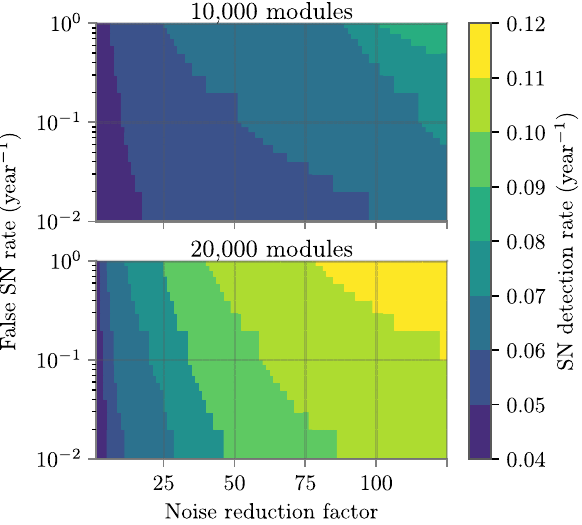
Fig. 10 CCSN detection rate for hypothetical detectors with 10,000 (upper) and 20,000 (lower) mDOMs as a function of the false SN detection rate and a reduction in radioactive noise compared to stan- dard mDOMs ( m ≥ 7, N ν ≥ 7). The CCSN detection rates have been calculated using the estimated CCSNe population from [16] based on actual observations and scaled to the star formation